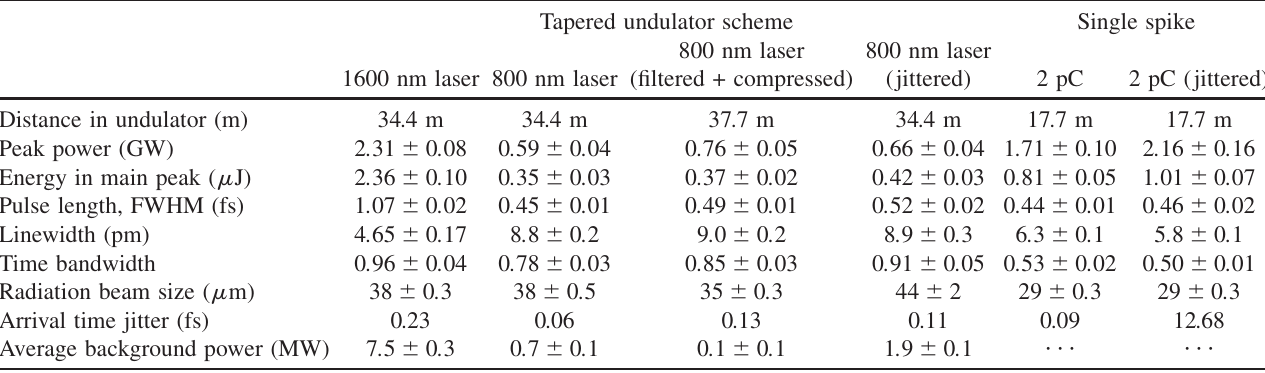
TABLE II. Table of FEL pulse properties taken as averages over 100